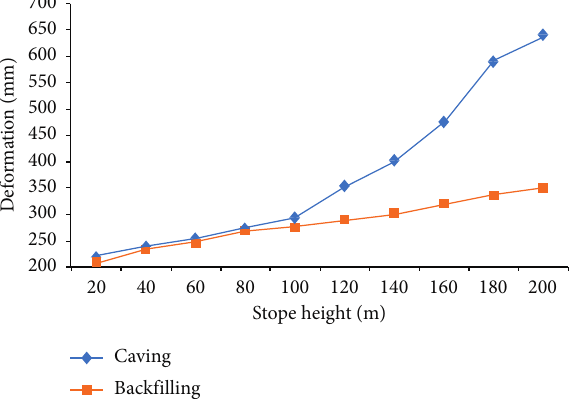
Figure 7: The maximum subsidence contrast